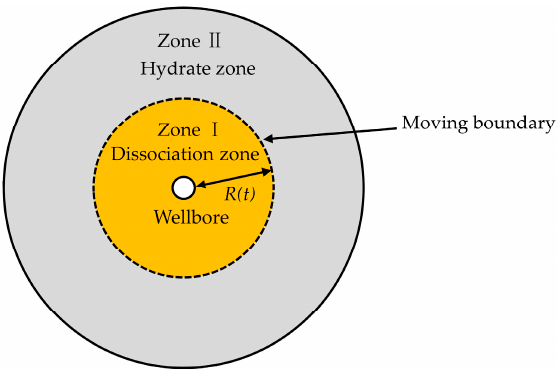
Figure 1. Schematic of hydrate dissociation in an infinite radially symmetrical region.